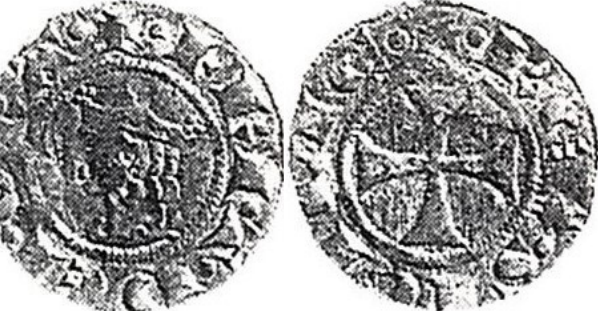
Figure 2. Denaro of Frederick III of Aragon, King of Sicily, obverse and reverse of billon silver coin, 1296–1337. Reproduced with permission of the Licensor. Image published in [18] (plate 43, image no. 780).